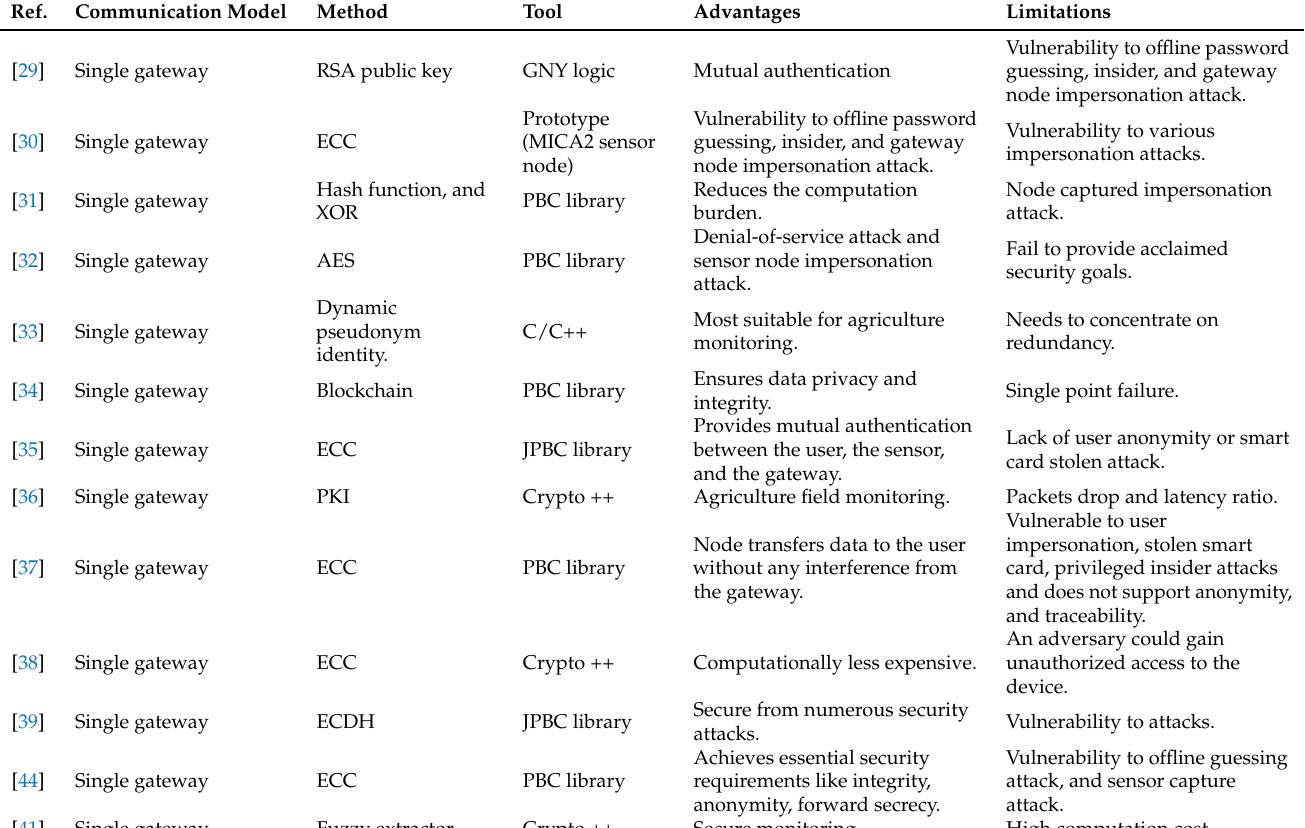
Table 1. Comparison of the existing WSN authentication scheme in the agricultural field.